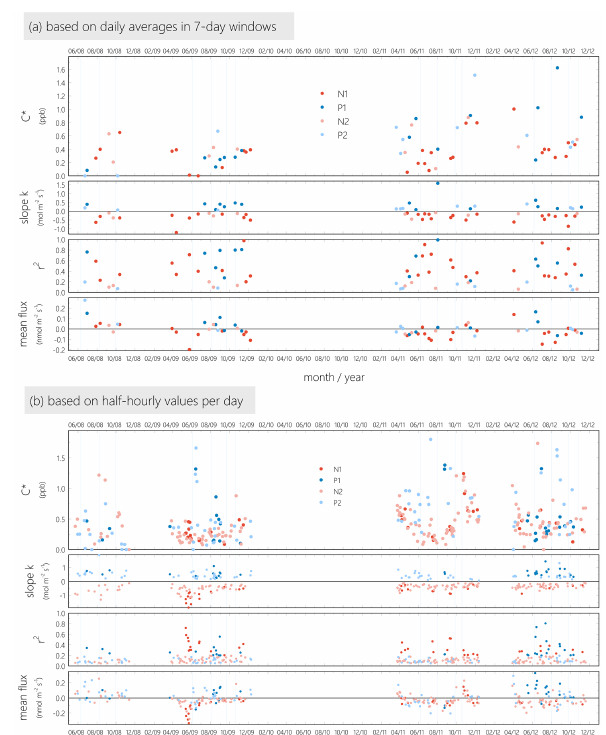
Figure 7. Results of a simple linear regression between acetalde- hyde VMR as the independent variable and flux as the depen- dent parameter, quantifying the compensation point ( C ∗ ), slope k , r 2 and the respective acetaldehyde flux on two different time scales. Panel (a) shows C ∗ calculated from daily average values in 7-day windows when a minimum of 4 days was present in each window. Panel (b) illustrates C ∗ and corresponding param- eters calculated from half-hourly values per day. Colors represent direction of correlation and goodness of fit between acetaldehyde VMRs and fluxes: N1...negative slope, r 2 > 0 . 2, N2...negative slope, 0 . 05 < r 2 < 0 . 2, P1...positive slope, r 2 > 0 . 2, P2...positive slope, 0 . 05 < r 2 < 0 . 2. All management data were excluded from the